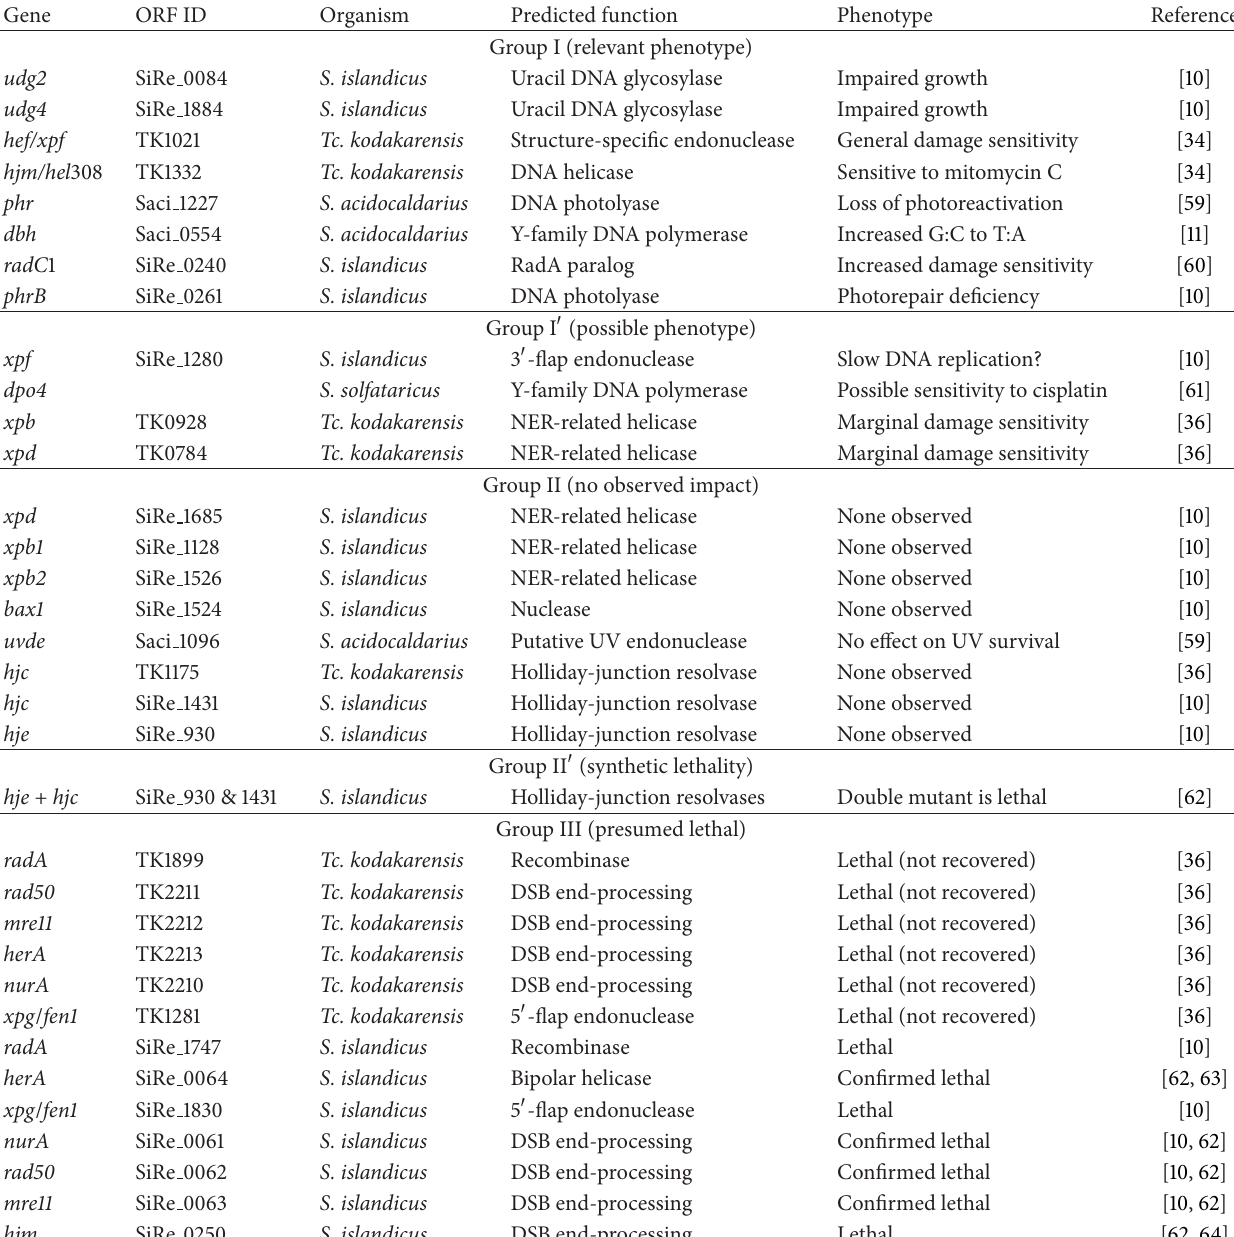
Table 1: Gene-deletion studies in hyperthermophilic